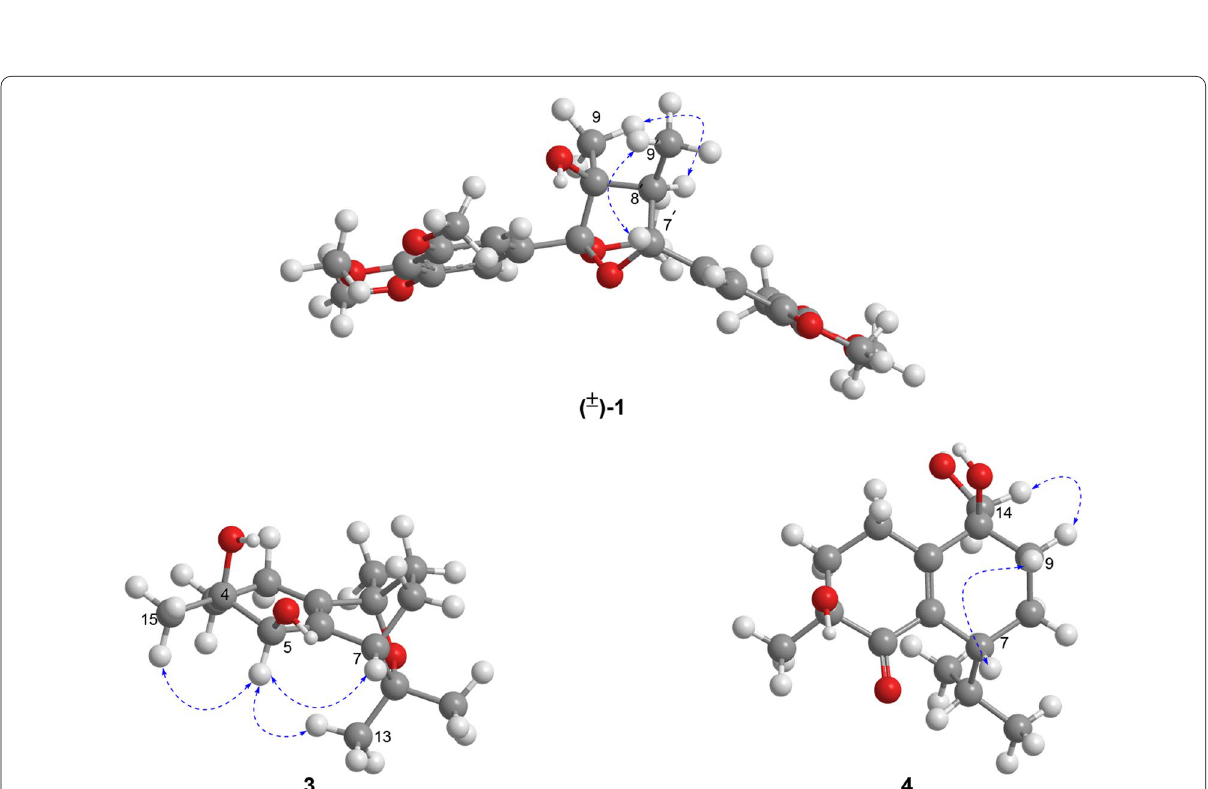
Fig. 3 Key ROESY correlations (blue dashed double‑headed arrow) of (